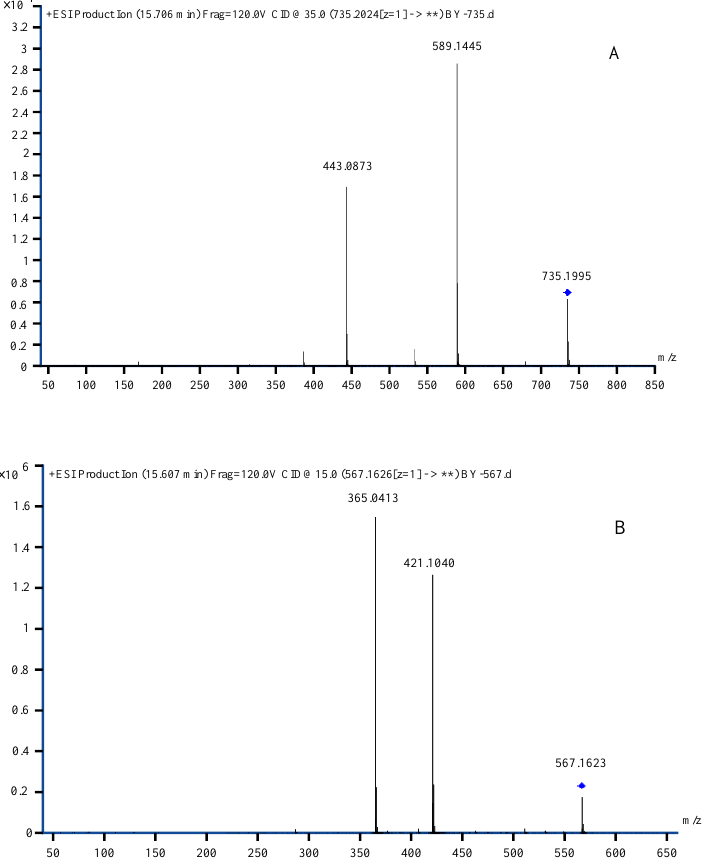
−2.14 ppm In Figure 13A, the parent ion was set as m / z 735.2024 and two product ions were formed. The parent ion m / z 735 lost 146, leading to the formation of m / z 589, and lost 146 + 146, leading to the formation of m / z 443. In Figure 13B, the parent ion was set as m / z